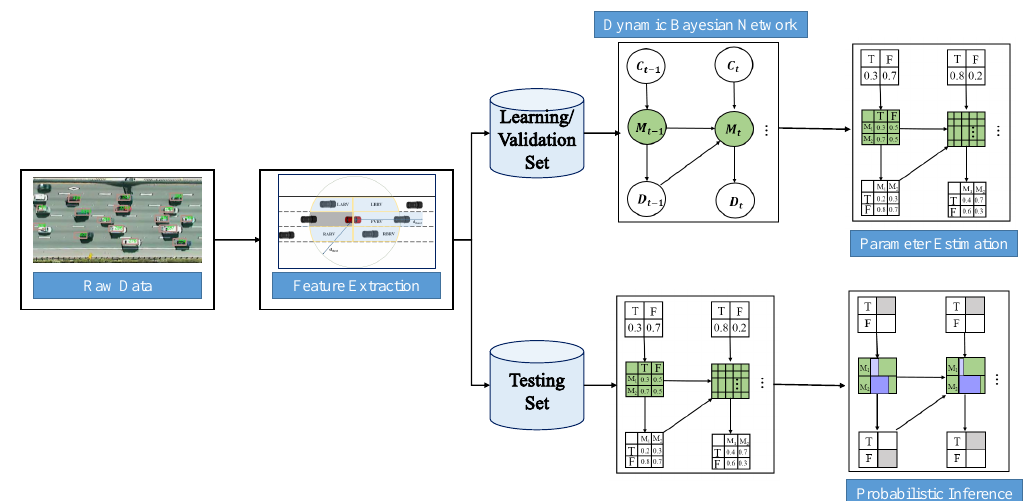
Figure 1. Framework of proposed maneuver-prediction